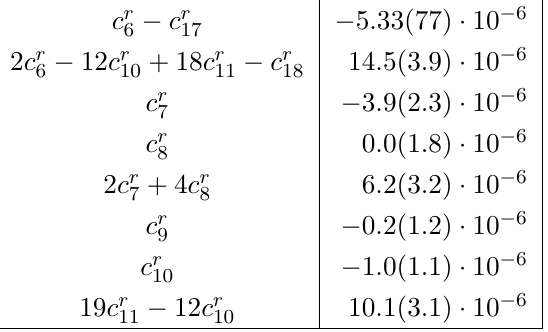
Table 4 . Numerical values of the combinations of SU(2) LECs at the scale (cid:22) (cid:22) = 770 MeV extracted from the 450 MeV cut-(cid:12)t of the partially quenched simulations in [45] (table 6). than the one extracted from the 370 MeV cut-(cid:12)t, the two are compatible for all reported combinations of LECs. In table 4 we quote the results expressed in terms of c r using the relations between SU( N ) and SU(2) LECs of [40]. i (cid:15) Ref. [45] provides estimates of 34 combinations of O ( p 6 ) three-(cid:13)avor LECs, C r . The i information of C r can be translated into a value for three combinations of c r by i i equating in the large m =m limit (and for (cid:11) = 0 and m (cid:17) m = m ) the n = 2 s em u d f and n = 3 formulas for the pion mass in eqs. (A.1) and (A.12), the pion decay f constant in eqs. (A.2) and (A.13) and the topological susceptibility in eqs. (A.8) and (A.16). Such a matching leads respectively to the three following